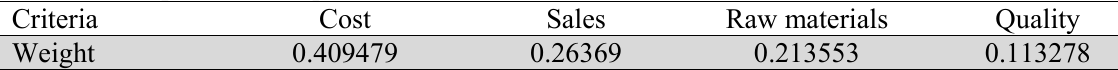
The results of pairwise comparison in section A